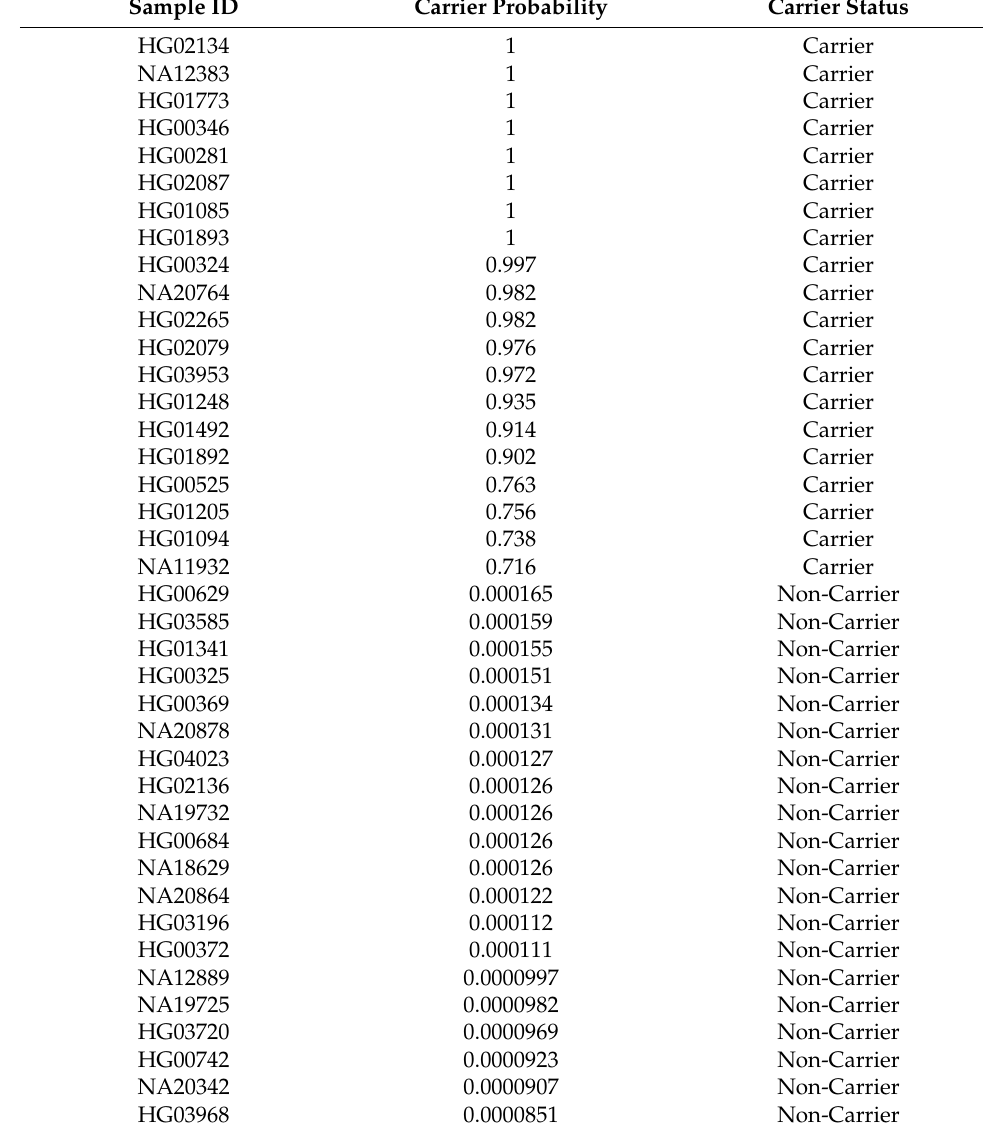
Table 1. 1000 Genomes Project sample